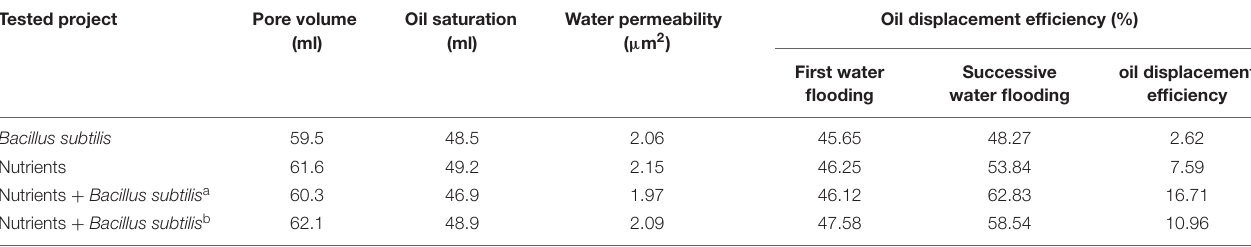
TABLE 2 | Core-flooding test showing the application potential of an exogenous lipopeptide-producing Bacillus subtilis M15-10-1 in assisting enhancement of oil recovery based on nutrient stimulation. Tested project